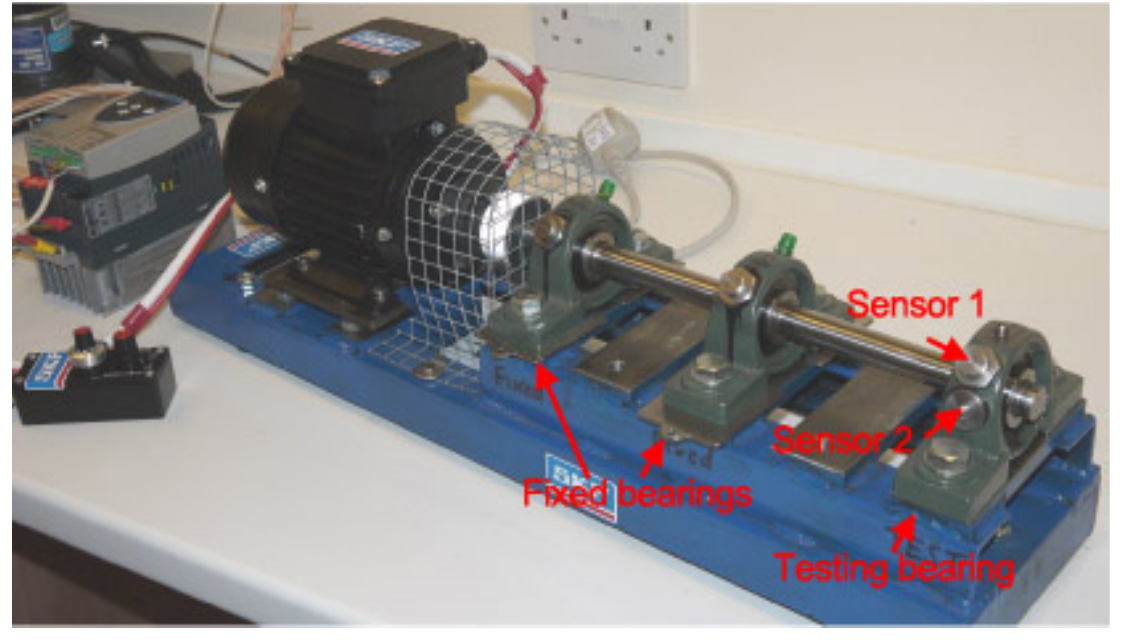
Figure 2. Experimental rig. Table 1. Test bearing specifications.